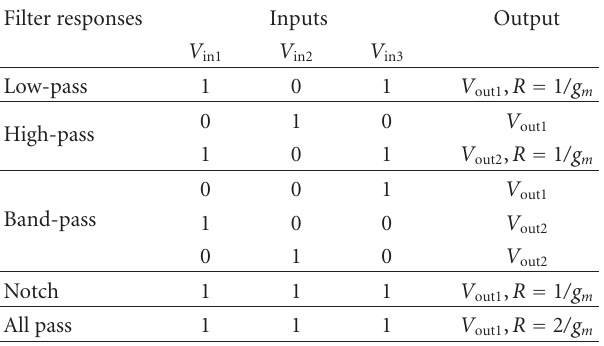
Table 2: The V in1 , V in2 , and V in3 values selection for each filter function